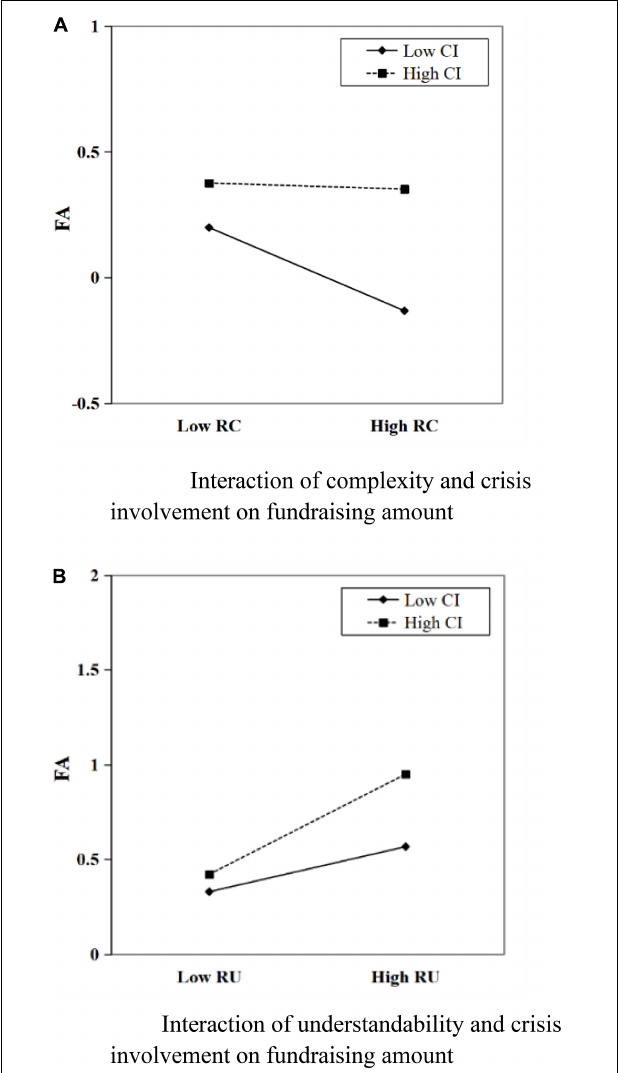
FIGURE 5 | (A) Interaction of complexity and crisis involvement on fundraising amount. (B) Interaction of understandability and crisis involvement on fundraising